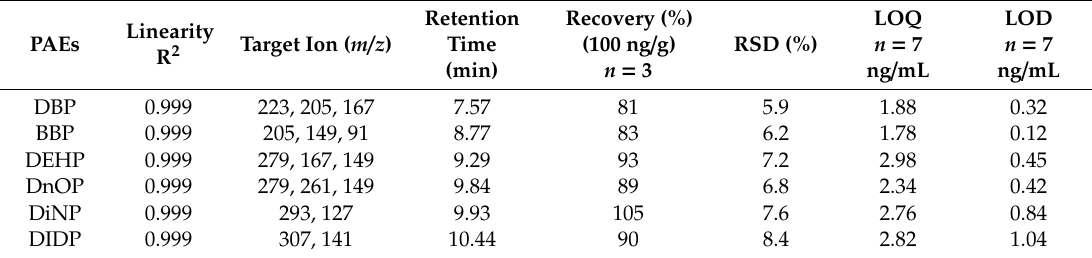
Table 1. Quality Assurance / Quality Control parameters for the extraction and analysis of six targeted Phthalate esters